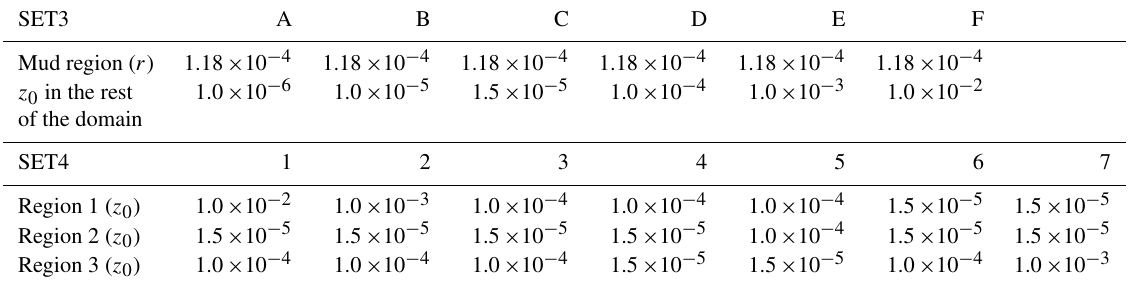
Table 1. Description of SET3 and SET4 (in